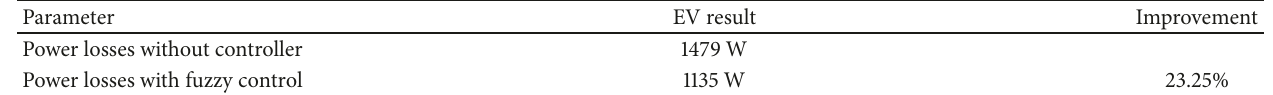
Table 6: Average values of power loss during a cycle trip.